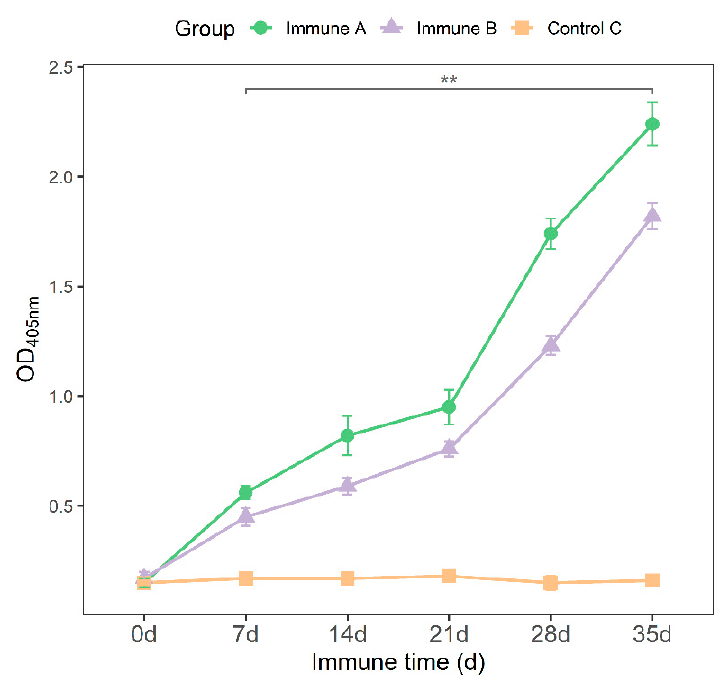
Figure 6. Antibody levels in the sera of piglets. The case groups were divided into groups A and B ( n = 3 per group) immunized with rMseno and E. coli -Mseno, respectively. The control group ( n = 3 per group) received an equal volume of PBS (C). Two stars above the black line indicate that immune groups A and B were highly significantly different compared to control group C at all points in time (7, 14, 21, 28, and 35 d). ** p < 0.01 shows a highly significant